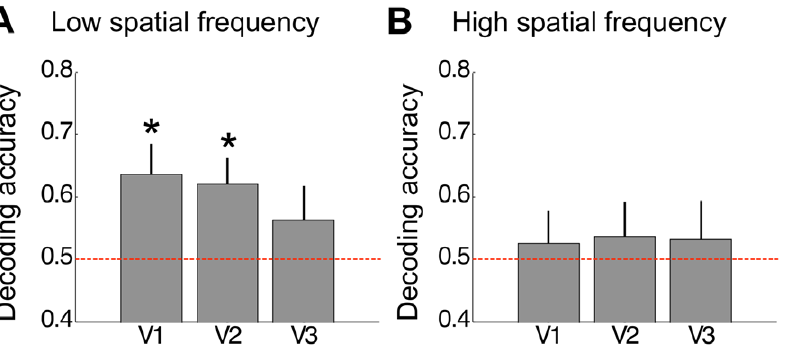
Figure 2. Decoding stimulus eye-of-origin for the low spatial frequency stimulus (A) and the high spatial frequency stimulus (B). Decoding accuracy (proportion correct) obtained for the 100 most discriminative voxels is plotted for the three ROIs averaged across participants. Error bars depict standard error of the mean. The asterisks indicate that accuracy was significantly above chance (permutation test, p , 0.01, Bonferroni corrected).